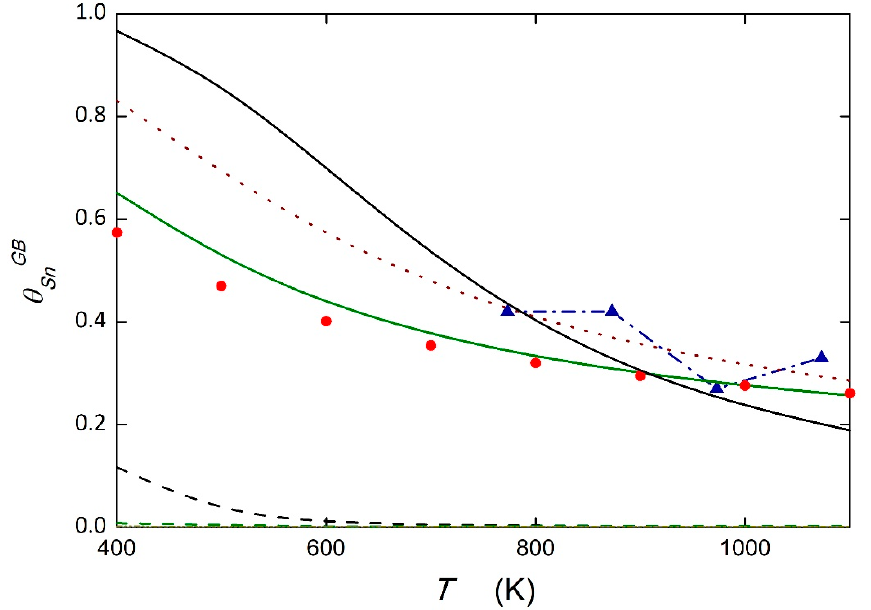
Figure 5. Sn concentration at the {013} grain boundary of bcc iron in the temperature range 400–1100 K. The red points are the values resulting from prediction [11]. The full lines represent the averaged concentration obtained from ML (green) and DFT (black) calculations with ∆ S Sn determined according to [12], and the dashed lines represent the respective calculations with ∆ S Sn determined according to [11]. The blue triangles are experimental data measured in a polycrystalline Fe–0.065 at% Sn alloy [25]. Table 3. Segregation energy calculated for the segregation of Sn at the {013} grain boundary. GB site, data calculated by ML and DFT in this work (0i, interstitial site, other sites are substitutional); PRED, prediction of Δ S Si according to models [11,12]; AVE, averaged segregation energy according to calculated data for sites determined according to Equation (9) with 𝜉 (cid:3038) = 1 and P = 14 or 12 (according to the number of considered grain boundary sites).